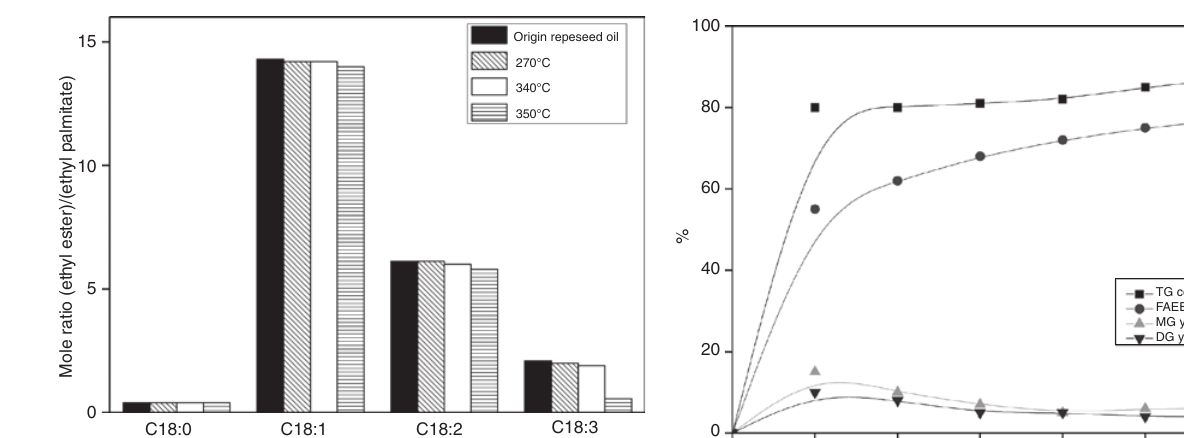
Figure 6: Molar ratio of ethyl ester to ethyl palmitate at different temperatures.